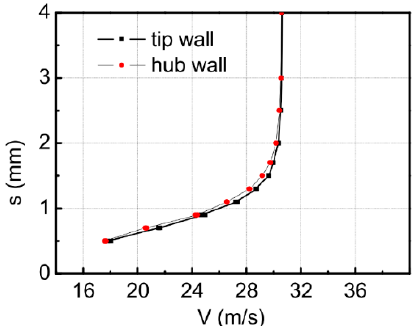
Figure 3. Velocity profiles at the hub and tip walls. Note that the y-axis is the vertical distance of test points to the wall.